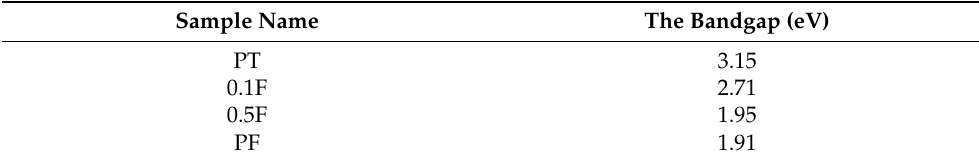
Figure 6. A plot of transferred Kubelka–Munk versus the energy of the light absorbed of (TiO 2 ) 1 − x (Fe 2 O 3 ) x nanoparticles. Table 2. The bandgap values of (TiO 2 ) 1 − x (Fe 2 O 3 ) x